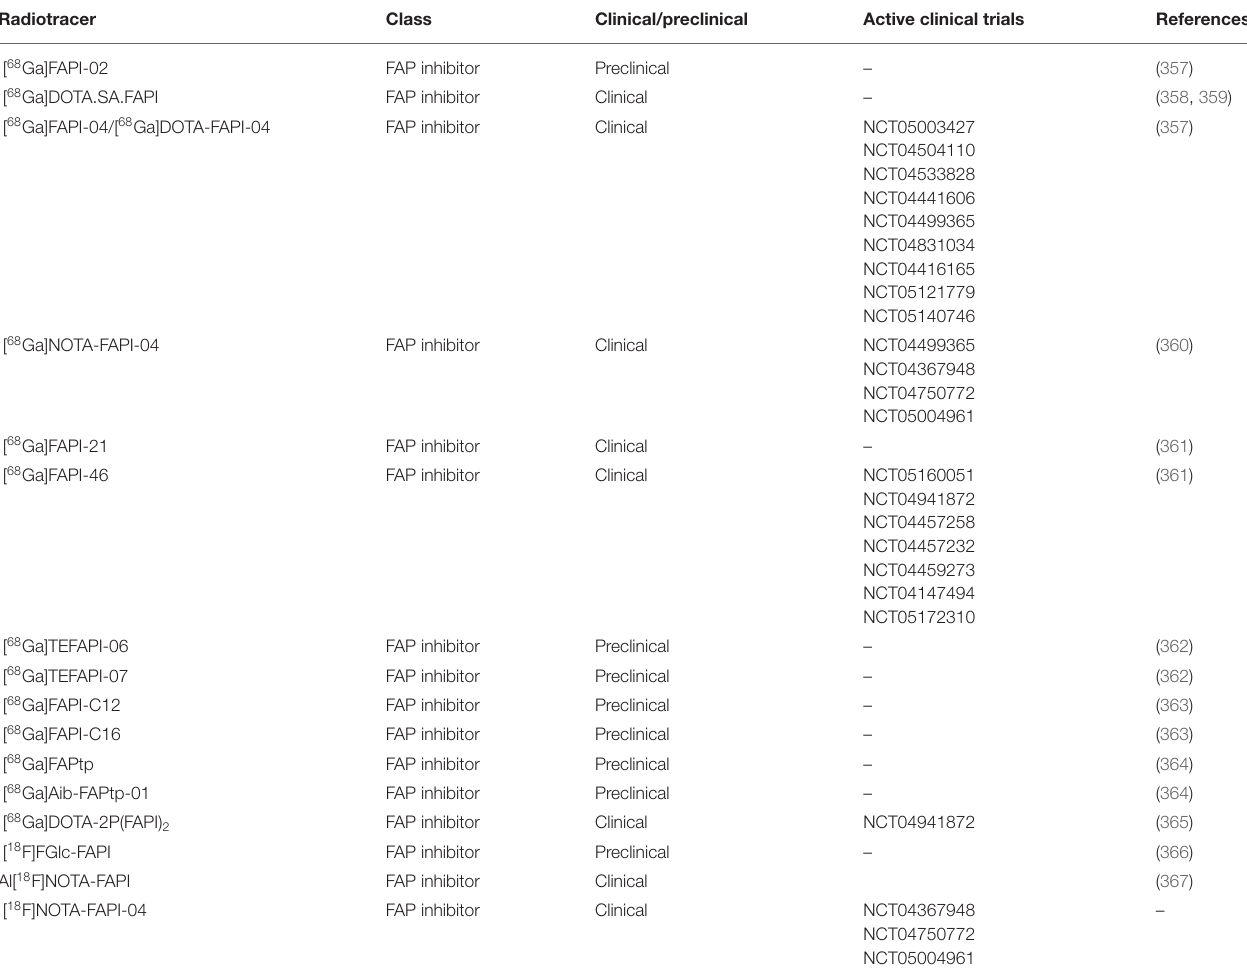
TABLE 4 | Fibroblast activation protein alpha (FAP) targeted PET